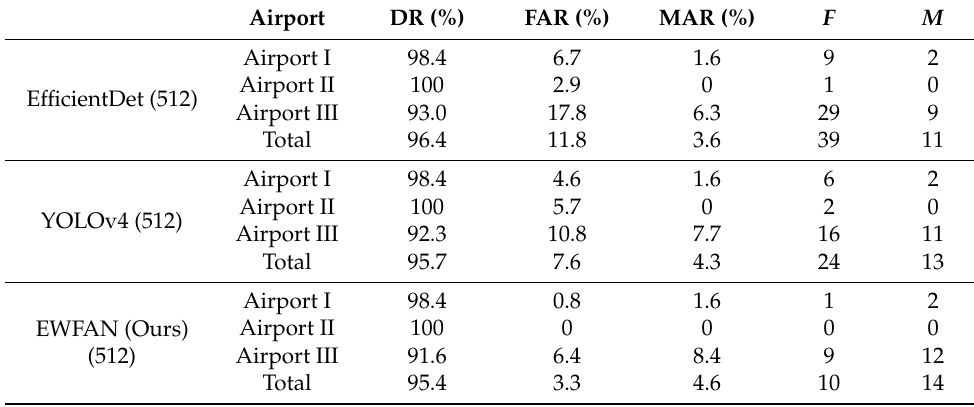
Table 5. Comparison of aircraft detection results from SAR images of different network. DR (%)